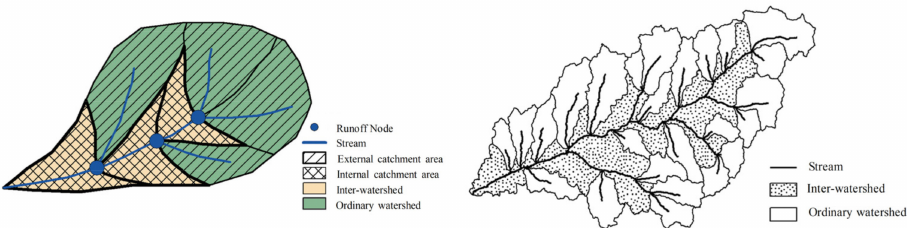
Figure 3. The diagram of the ordinary and inter-watersheds (this figure is cited from [39]).